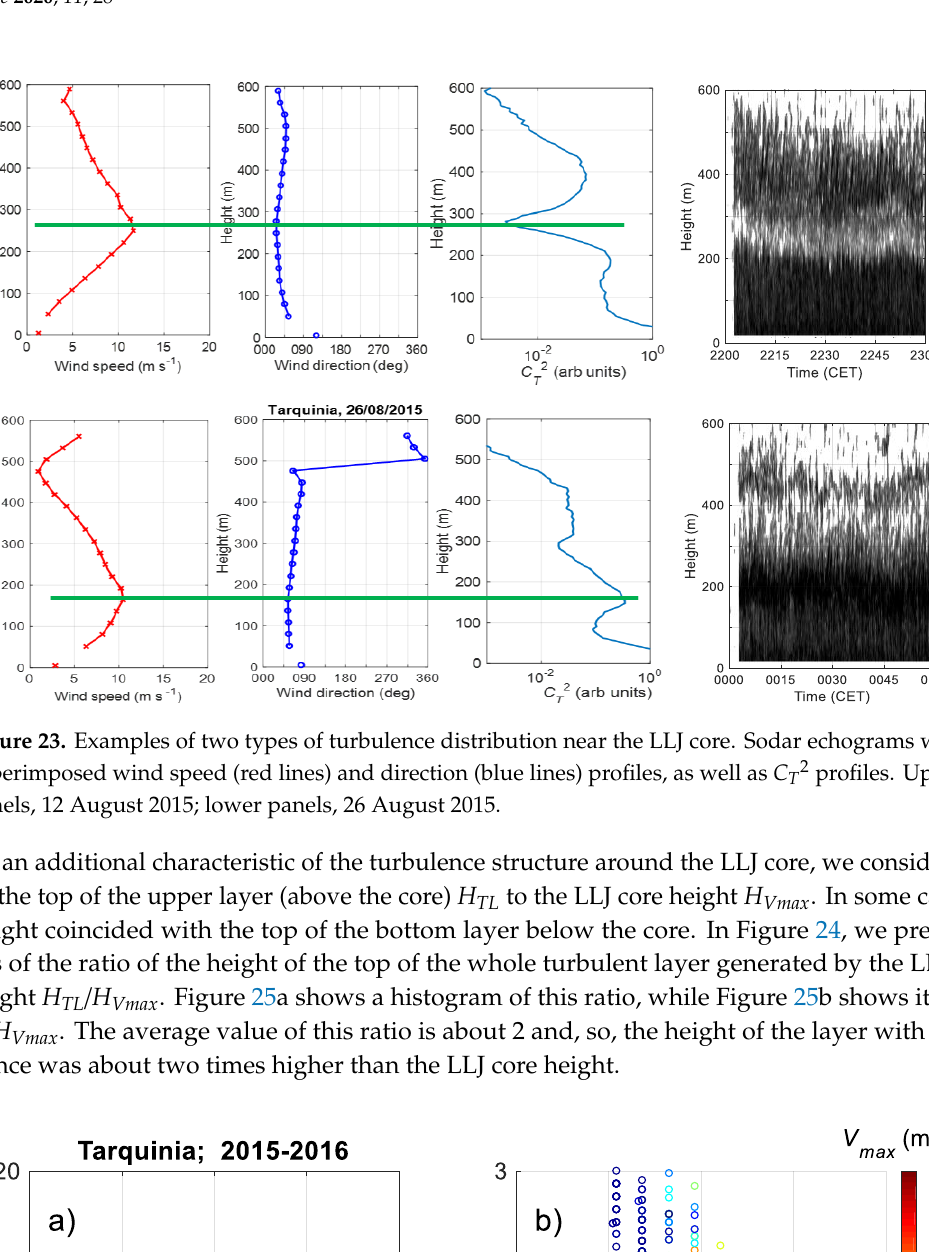
and ( b ) values of HTL / H versus H . Colours of Vmax Vmax Vmax